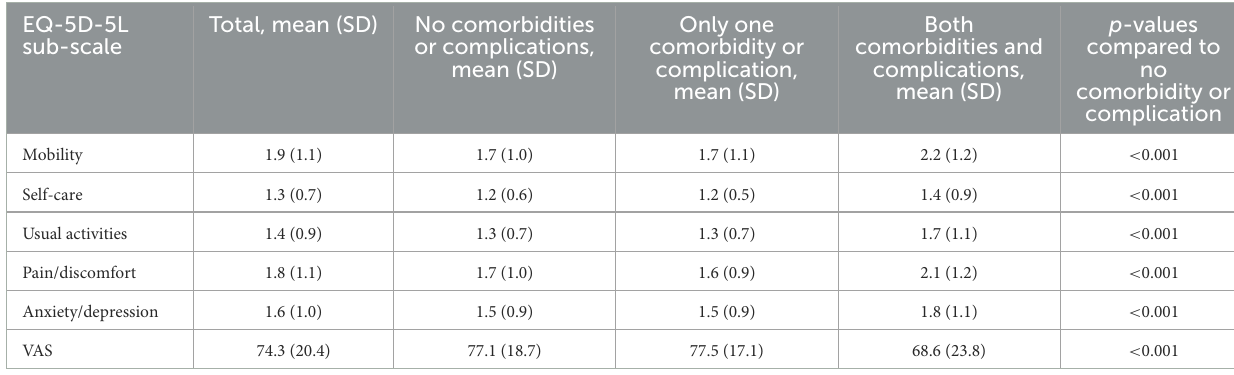
TABLE 3 EQ-5D-5L sub-scales scores by comorbidity and complication status. EQ-5D-5L sub-scale